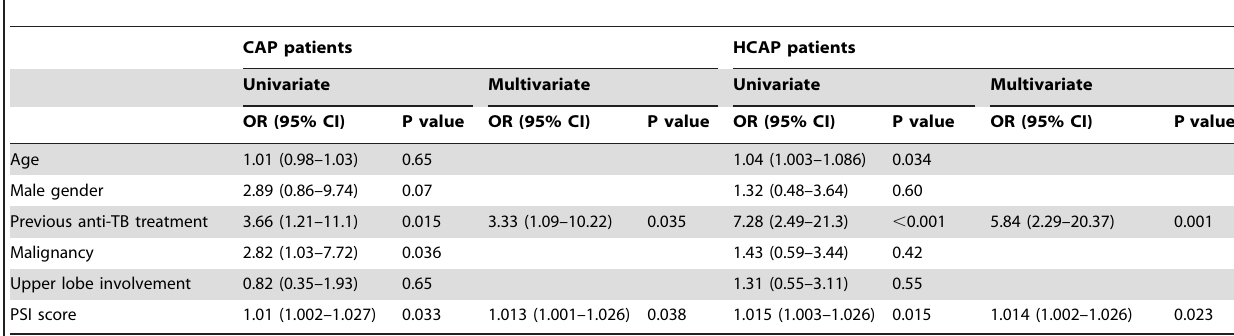
Table 4. Univariate and multivariate logistic regression analysis of predictors associated with concomitant pulmonary tuberculosis in hospitalized HCAP and CAP patients a